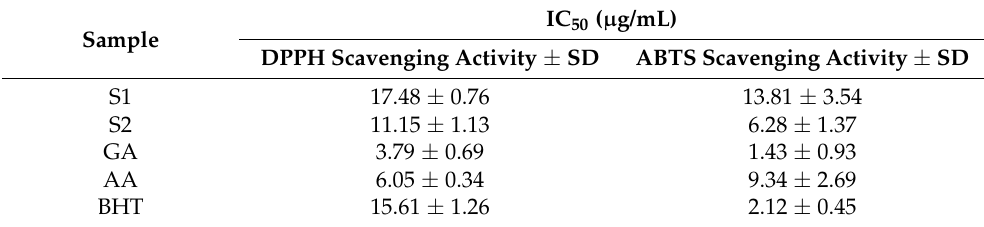
Table 2. Antioxidant activity in the DPPH and ABTS tests of Sideritis sipylea essential oils extracted from wild-growing Greek material (S1: mid-summer collection, Samos Island; S2: early summer collection, Lesvos Island) compared to reference antioxidants (GA: gallic acid, AA: ascorbic acid, BHT: butylated